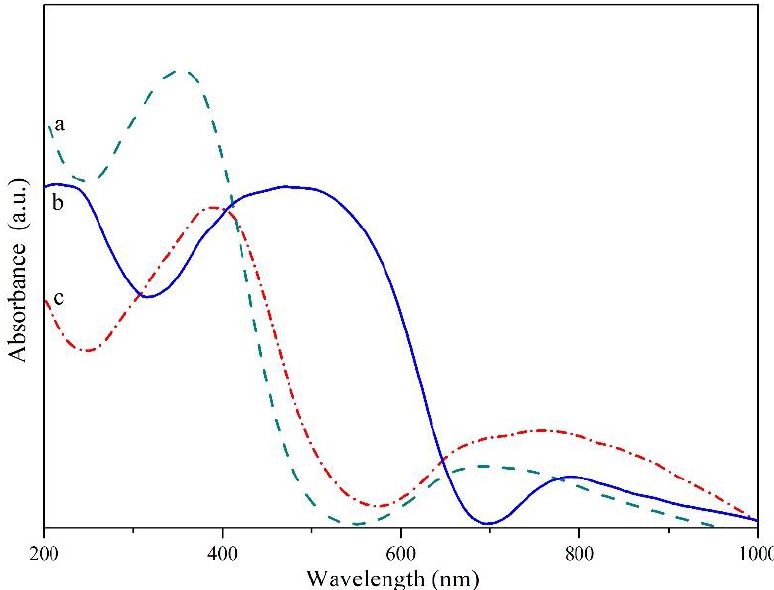
Figure 3. UV-Vis absorption spectra of: ( a ) CuTa 2 O 6 (x = 0), ( b ) CuV 2 O 6 , ( c ) CuTa 1.70 V 0.30 O 6 (x = 0.30).